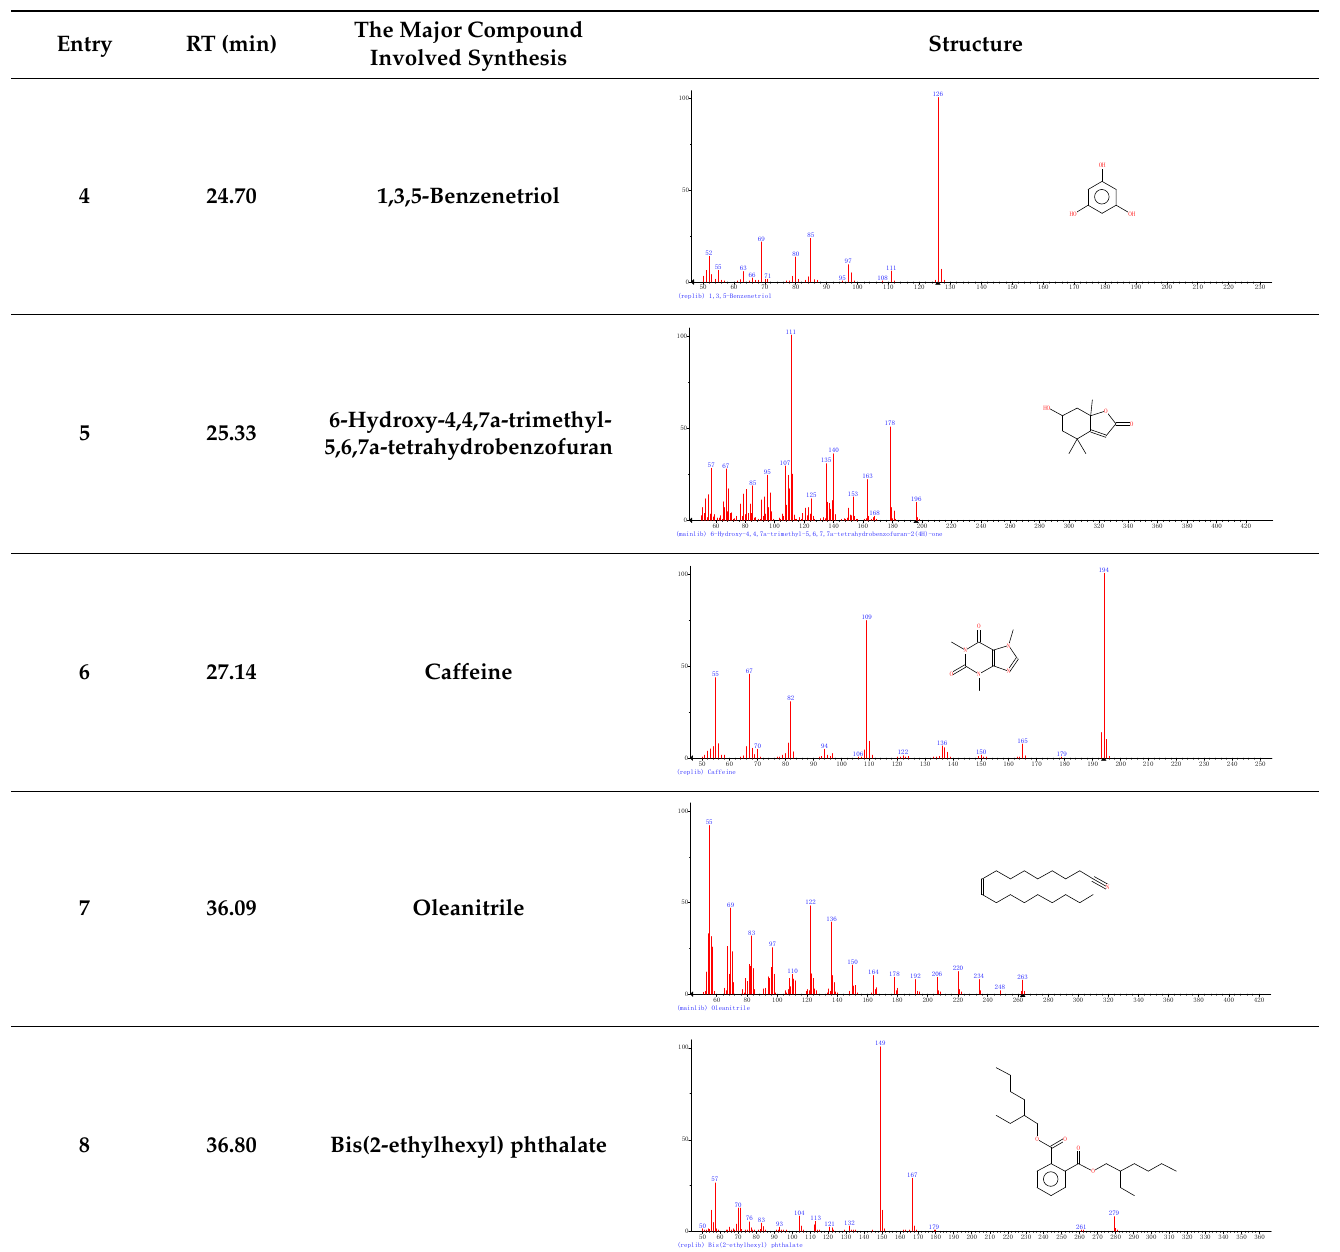
9 of 14 Figure 7. GC-MS chromatograms of GT (upper line) and n Fe (lower line). Table 1. Mass spectrometry classification of the main biomolecules in GT. Entry RT (min) The Major Compound Involved